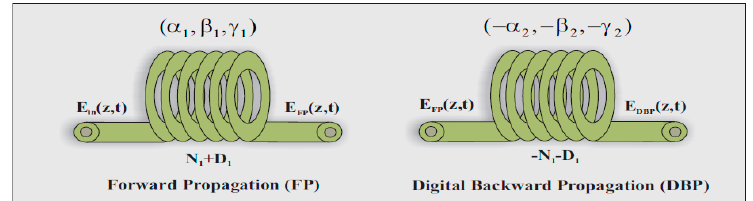
Figure 1. Digital back ‐ propagation (DBP) conceptual diagram [11].